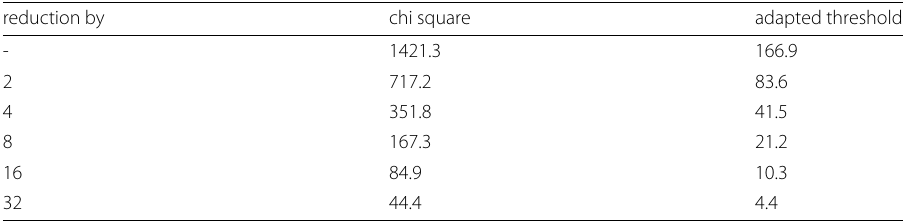
Table 3 Algorithm execution time (in seconds) on a trace of 10 min length reduction by chi square adapted